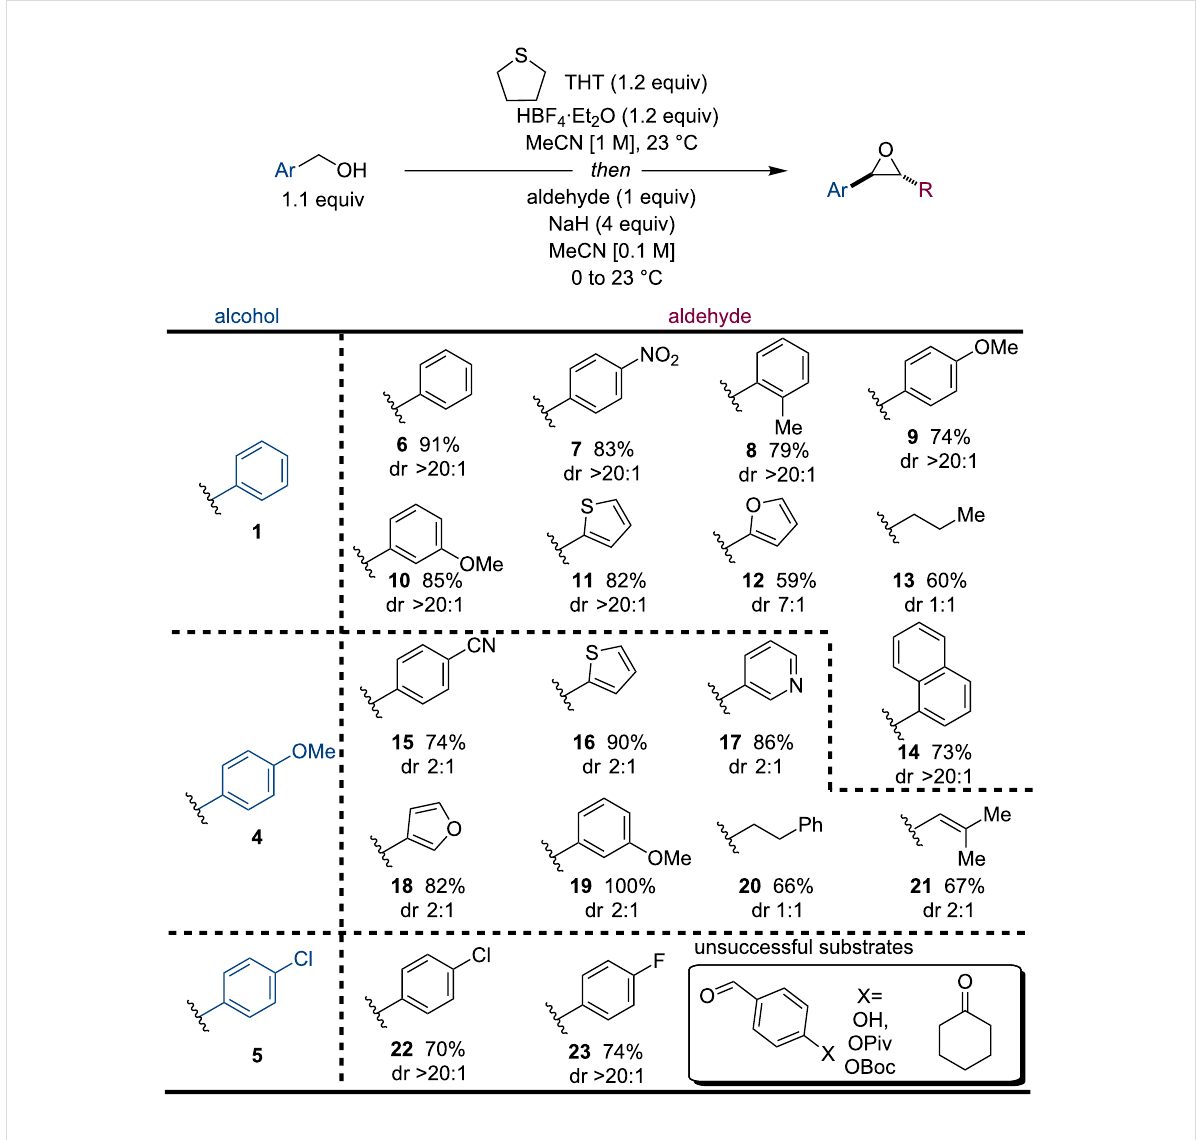
Figure 1: Scope of the one-pot synthesis of epoxides from benzyl alcohols and aldehydes.